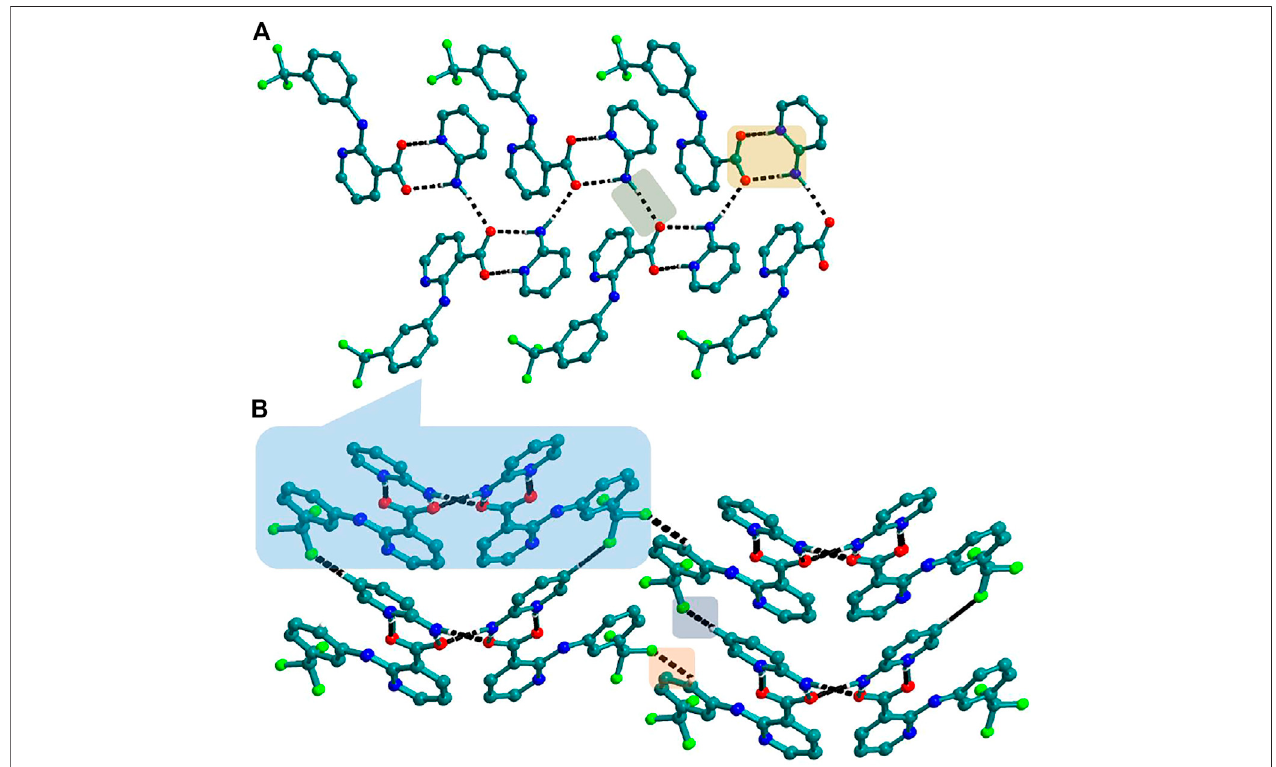
FIGURE 6 | (A) Nif ─ 2ap dimers interacted with other dimers via N ─ H ··· O to form a 1D Chain in 4 . (B) The chains are connected through C ─ H ··· F in the other two planes forming a 3D network.